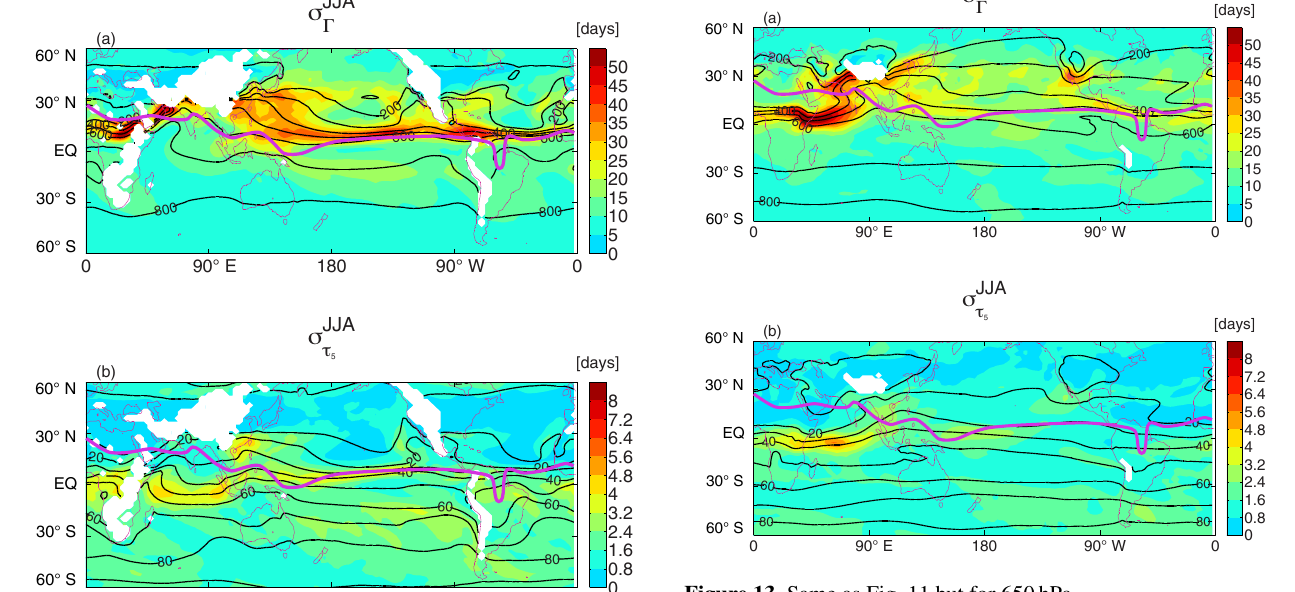
Figure 13. Same as Fig. 11 but for 650hPa. meridional gradients; e.g., there are weak (cid:48) gradients in the tropical Indian Ocean but large τ 5 gradients in southern trop-